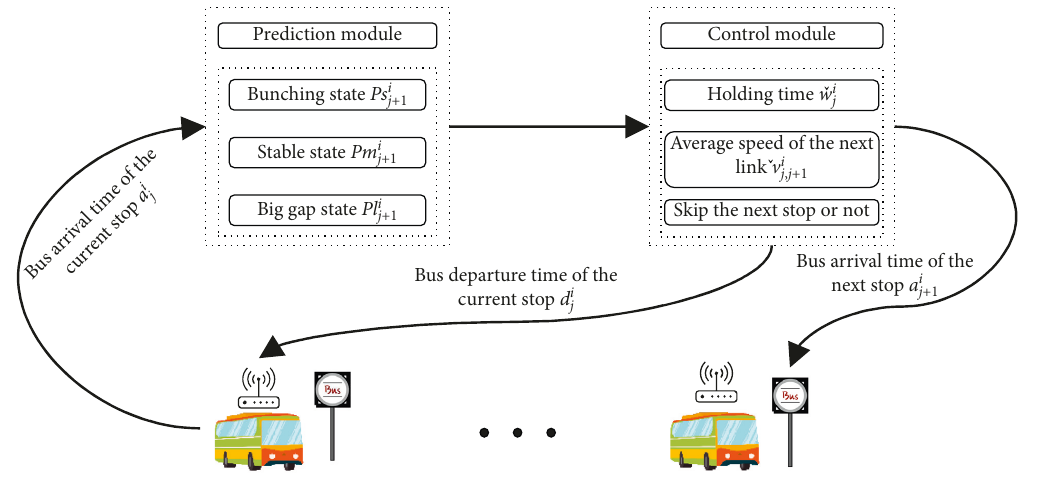
Figure 6: Description of the predictive-control